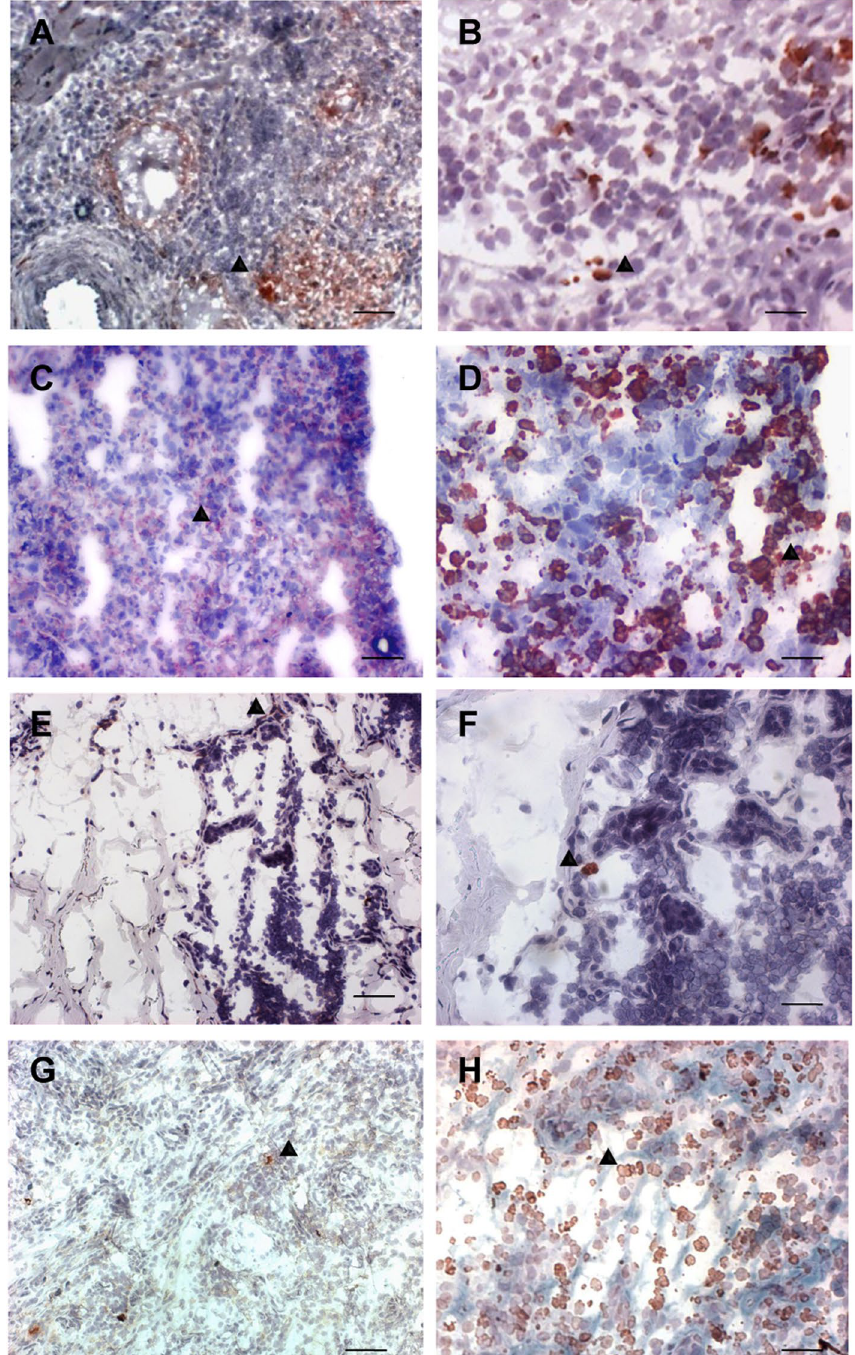
Figure 2. NOS2 expression ( A , C , E , G ) and neutrophils ( B , D , F , H ) in active lesions of LCL-ATL ( A , B ), SCL-ATL ( C , D ), F-SP ( E , F ) and LC-SP ( G , H ) patients. Magnification ( A , C , E , G ) 200 × scale bar = 50 µ m and ( B , D , F , H ) 400 × scale bar = 25 µ m. LCL-ATL: localized cutaneous leishmaniasis; SCL-ATL: sporotrichoid cutaneous leishmaniasis; F-SP: fixed sporotrichosis; LC-SP: Lymphocutaneous sporotrichosis. Arrows demonstrate examples of positive